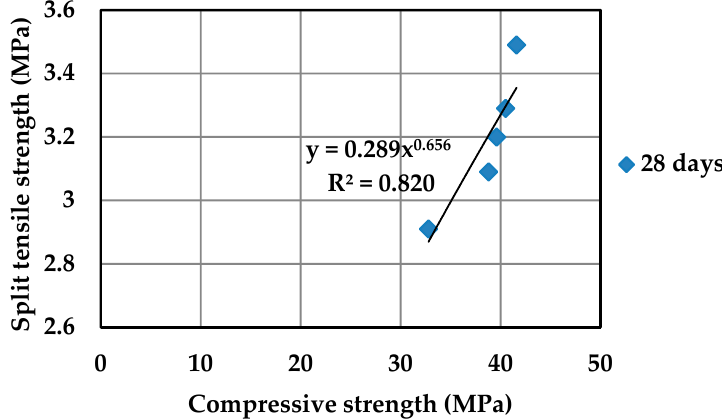
Figure 12. Correlation graph between compressive and split tensile strength. 308